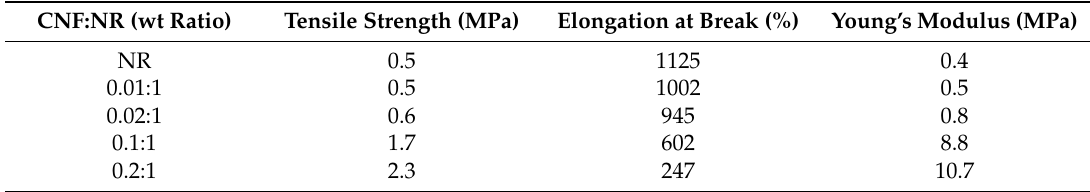
Table 1. Mechanical properties of CNF-NR composite sheets under tensile mode.